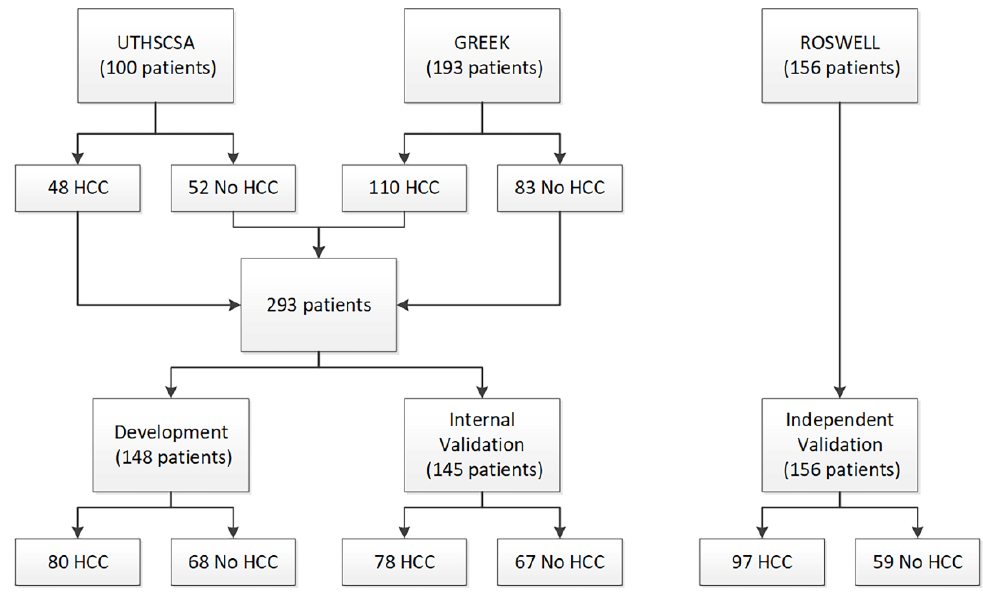
Figure 1. Consort diagram.